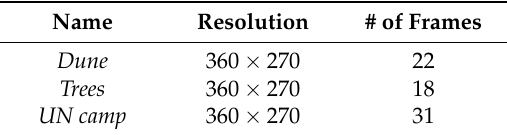
Table 4. Dataset 2 description.